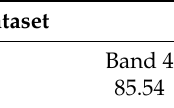
) that is lower than the estimation variance ( σ 2 P